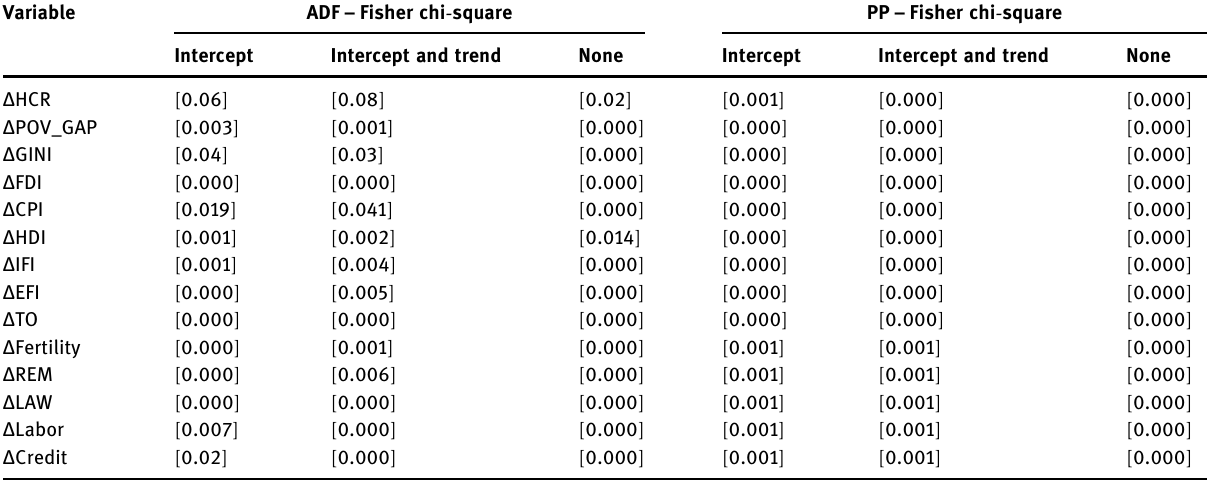
Table A4: Panel unit root test